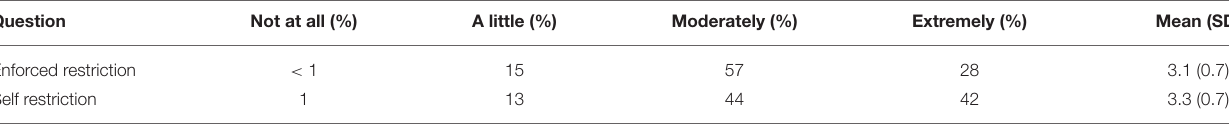
TABLE 4 | Responses on the Strictness of Guidelines for Measures against COVID-19. Question Not at all (%)